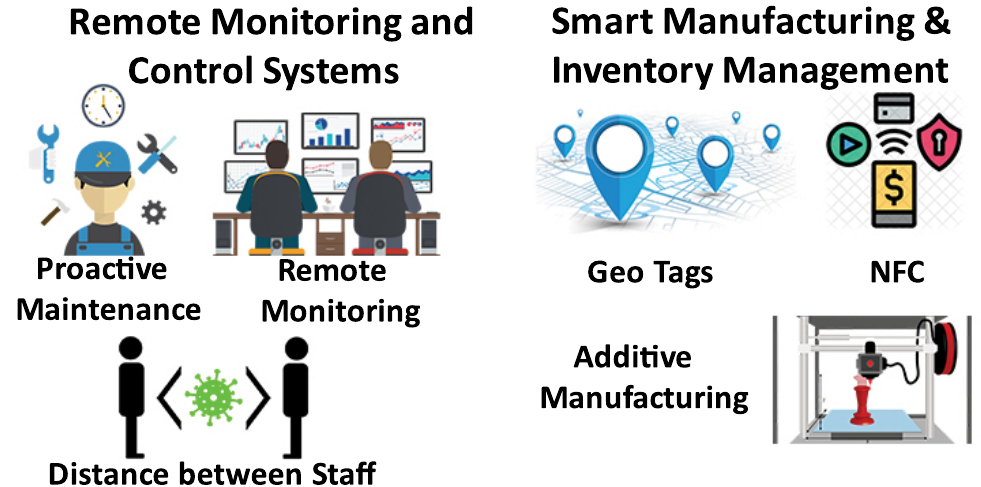
Figure 7. Recent Increased Adoptions in Industries in Wake of